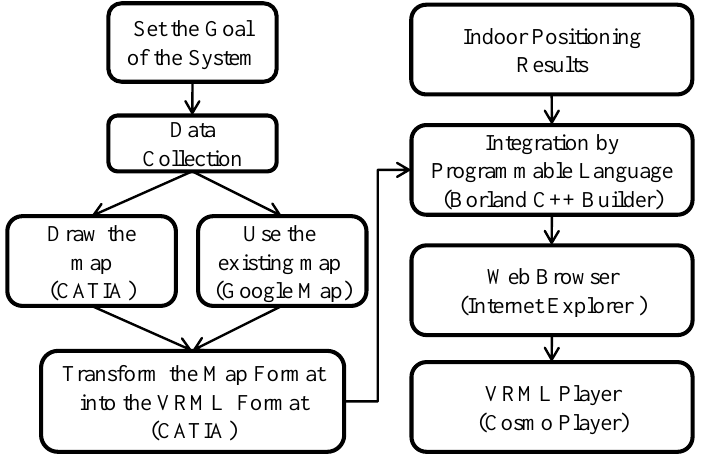
Figure 7. The proposed developmental procedure of the indoor GIS.